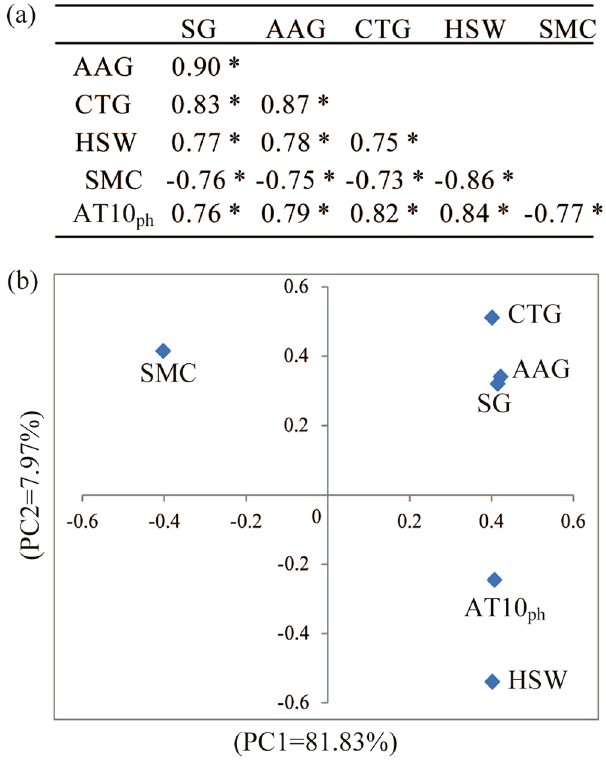
Figure 1. Relationships of seed-related traits. ( a ) Correlation between each pair of the investigated traits. ( b ) Principle component analysis (PCA) of the investigated traits. Seeds were collected at 11 different growth stages that were generated from 8 environments to evaluate three vigor traits (standard germination, SG; accelerated aging germination, AAG and cold test germination, CTG), two physiological traits (hundred-seed weight, HSW and seed moisture content, SMC), and an ecological trait ( ≥ 10 °C accumulated temperature from pollination to harvest, AT10 ph ). * Indicates a significant correlation at p <